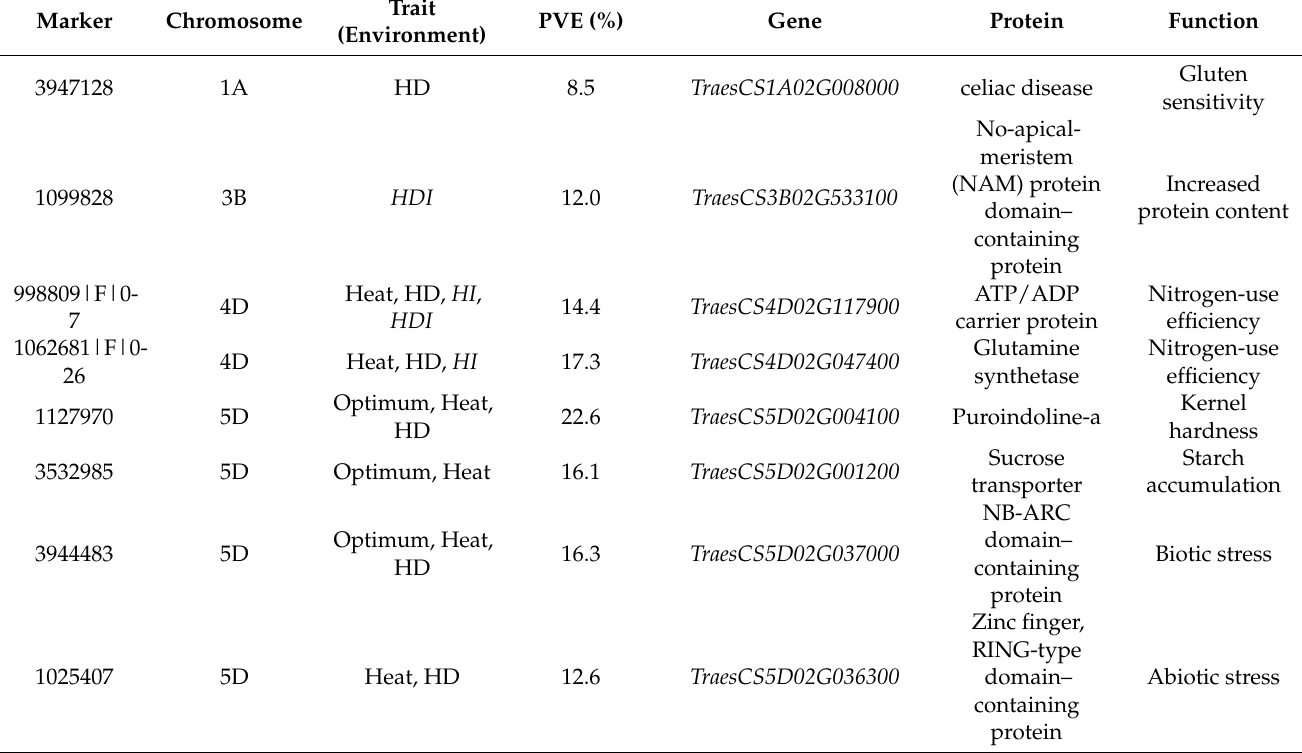
Table 3. Candidate genes for hardness under optimum, heat, and combined heat-drought (HD) and hardness indexes ( HI , HDI